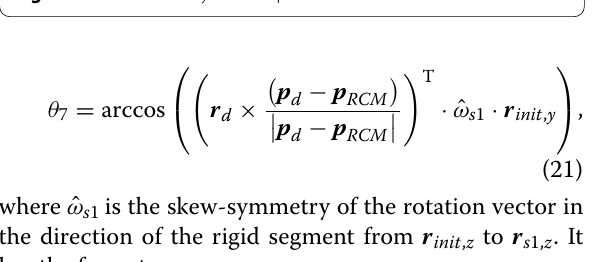
Figure 10 Motion of hysteroscope with RCM constraint